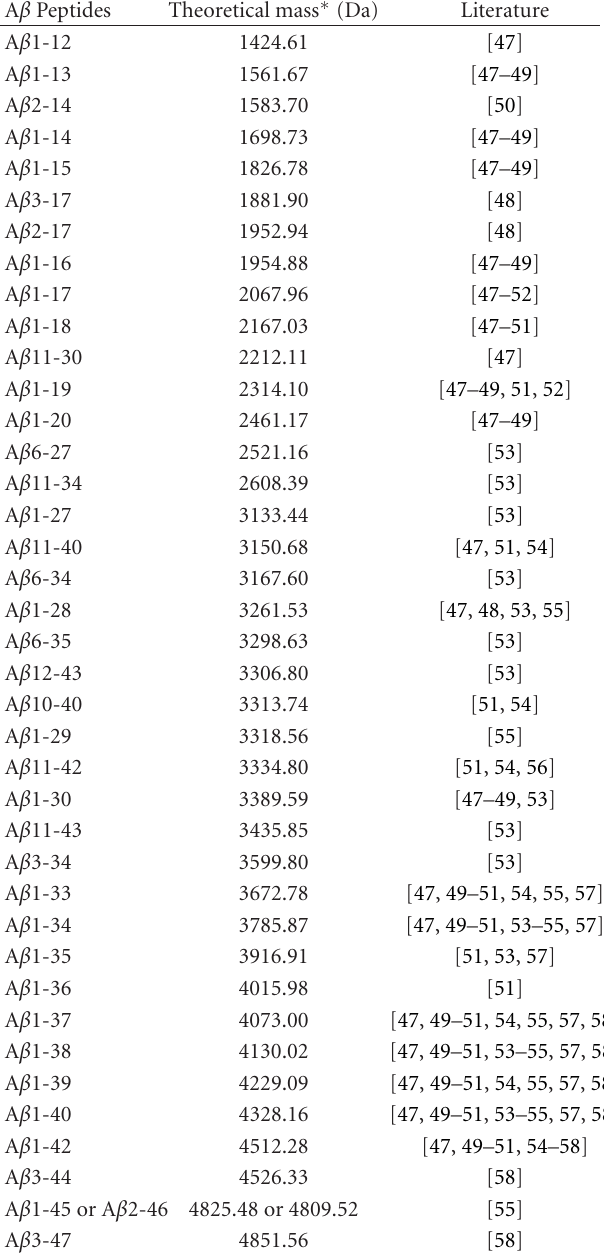
Table 1: Summary of A β peptides in human